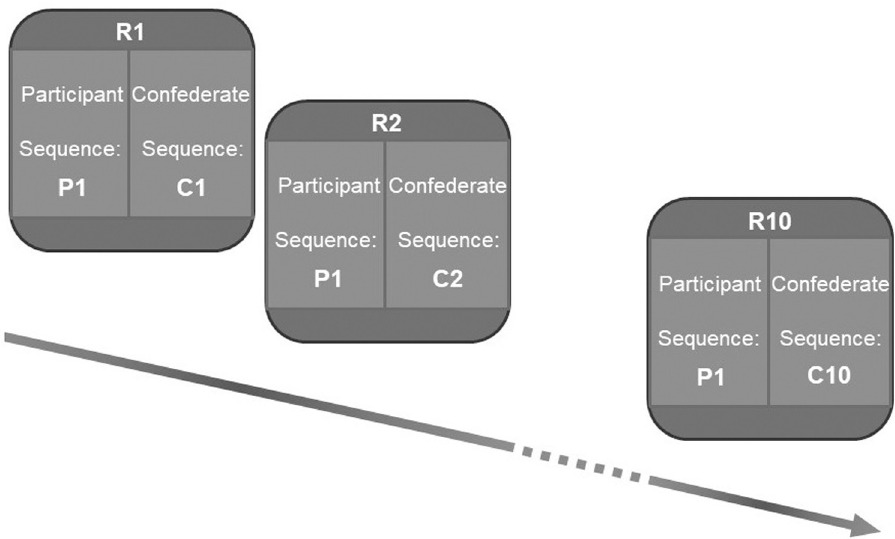
Fig 3. Manipulation of variability and predictability in Experiment 1. Only a single block is shown in the figure. Variability in both groups are manipulated by varying the inter-personal target distances. Predictability was manipulated by making the participant repeat the same movement sequence (P1) across repetitions R1-R10, while the confederate performs 10 different sequences (C1-C10) across R1-R10, to produce completely unpredictable